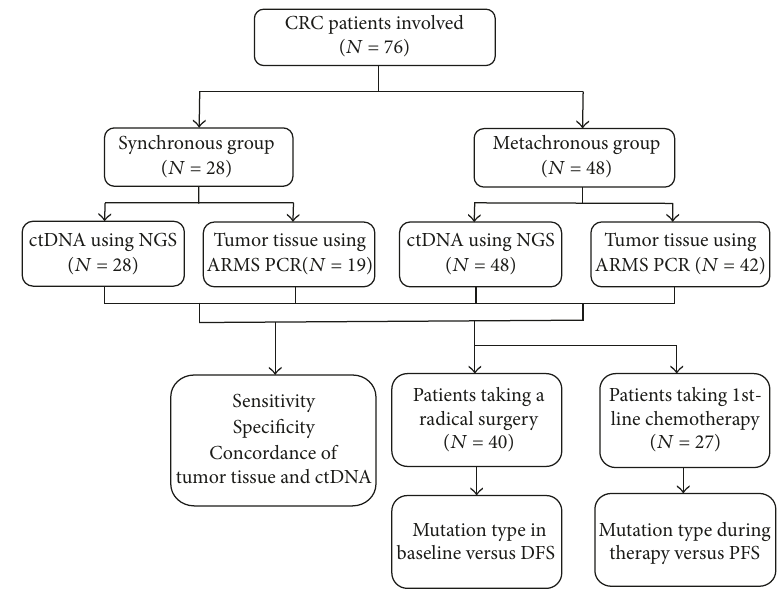
Figure 1: Overview of the work